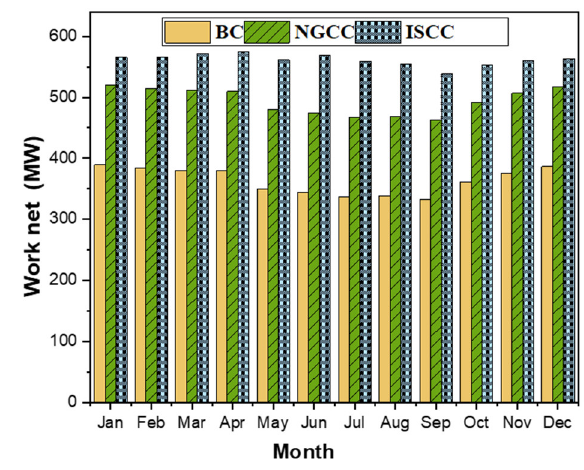
Figure 7. The power produced for B.C., NGCC, and ISCC per month.